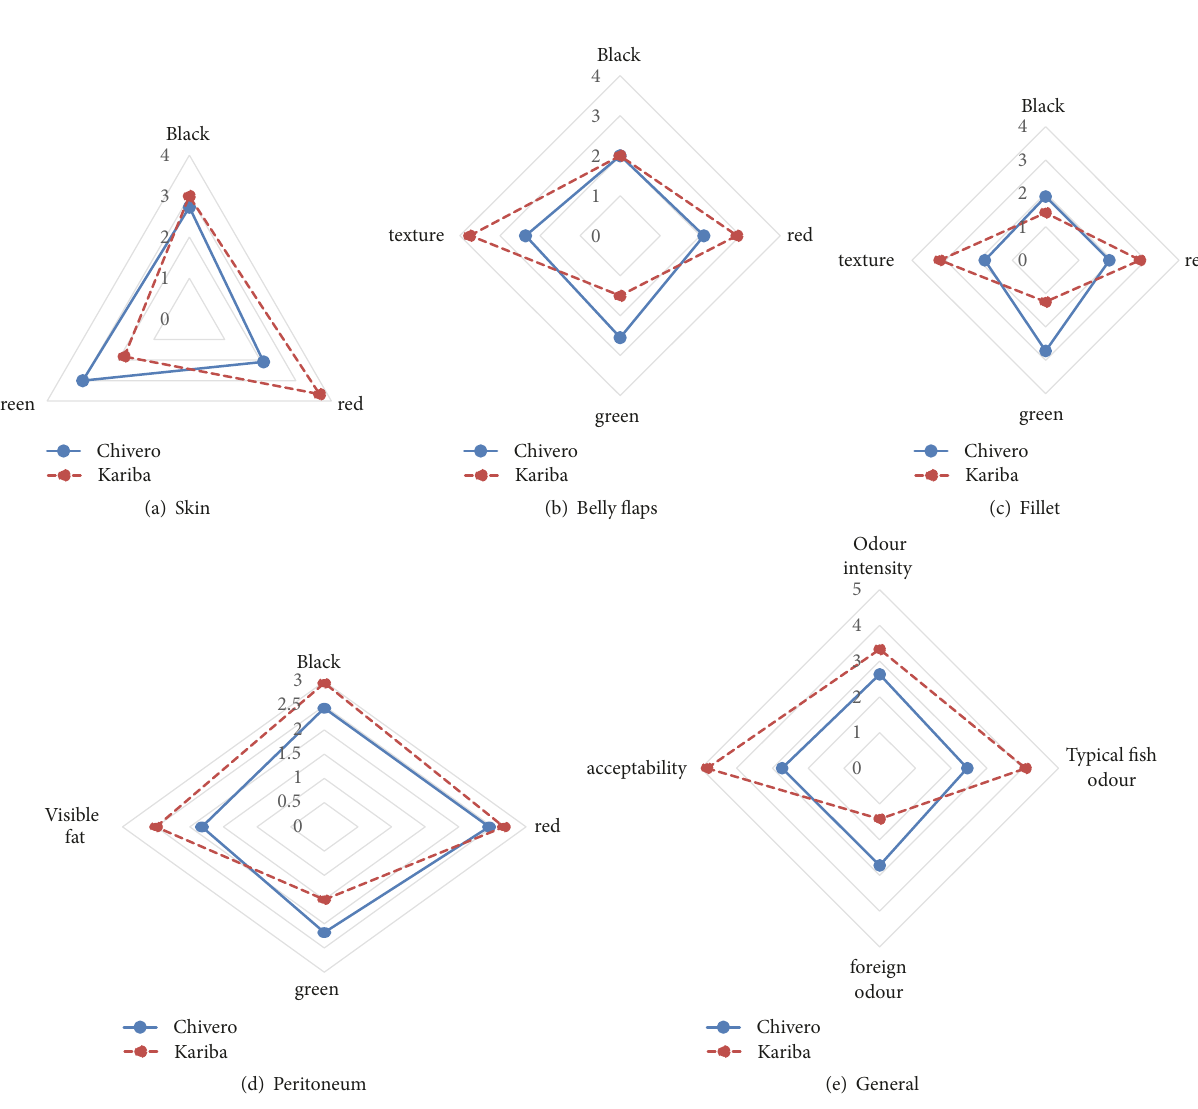
Figure 1: Comparison of raw Nile tilapia from Lake Kariba and Lake Chivero. (a) Colour of fish skin. (b) Colour and texture of belly flaps. (c) Appearance of peritoneum. (d) Colour and texture of fillets. (e) General odour and acceptability of the